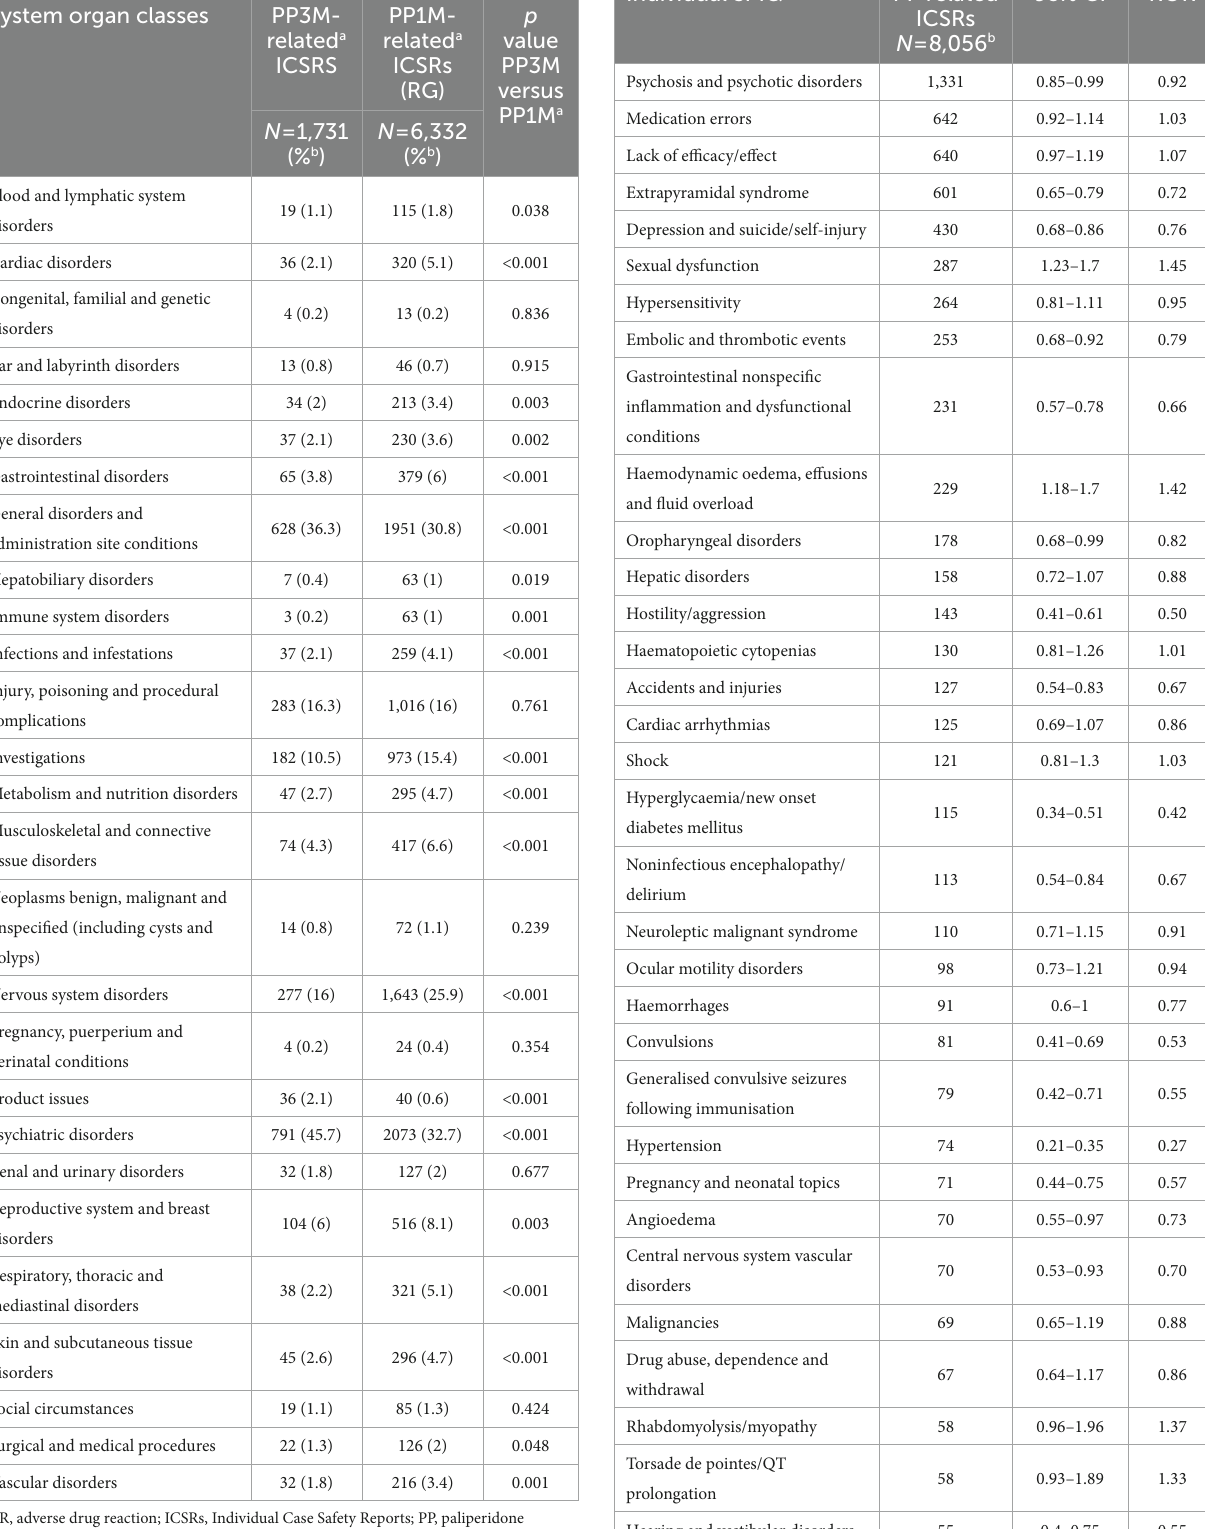
TABLE 4 Reporting odds ratios for PP-related ICSRs as compared to RG using standardized MedDRA